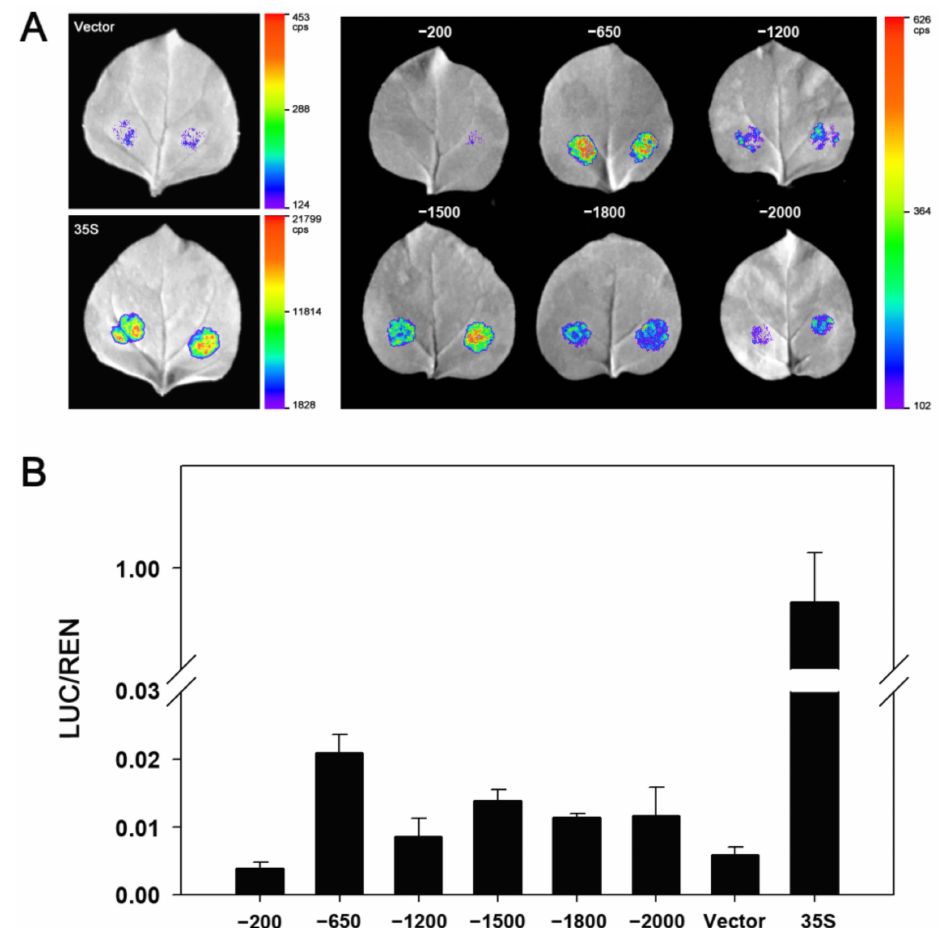
Figure 8. Identification of the core region of ZmDi19-5 promoter. ( A ) LUC-expressed activity driven by different truncated ZmDi19-5 promoter, and 35S:LUC construct (35S) and pGreenII 0800-LUC empty vector (Vector) were used as the controls, respectively; ( B ) Quantitative analysis of LUC- expressed